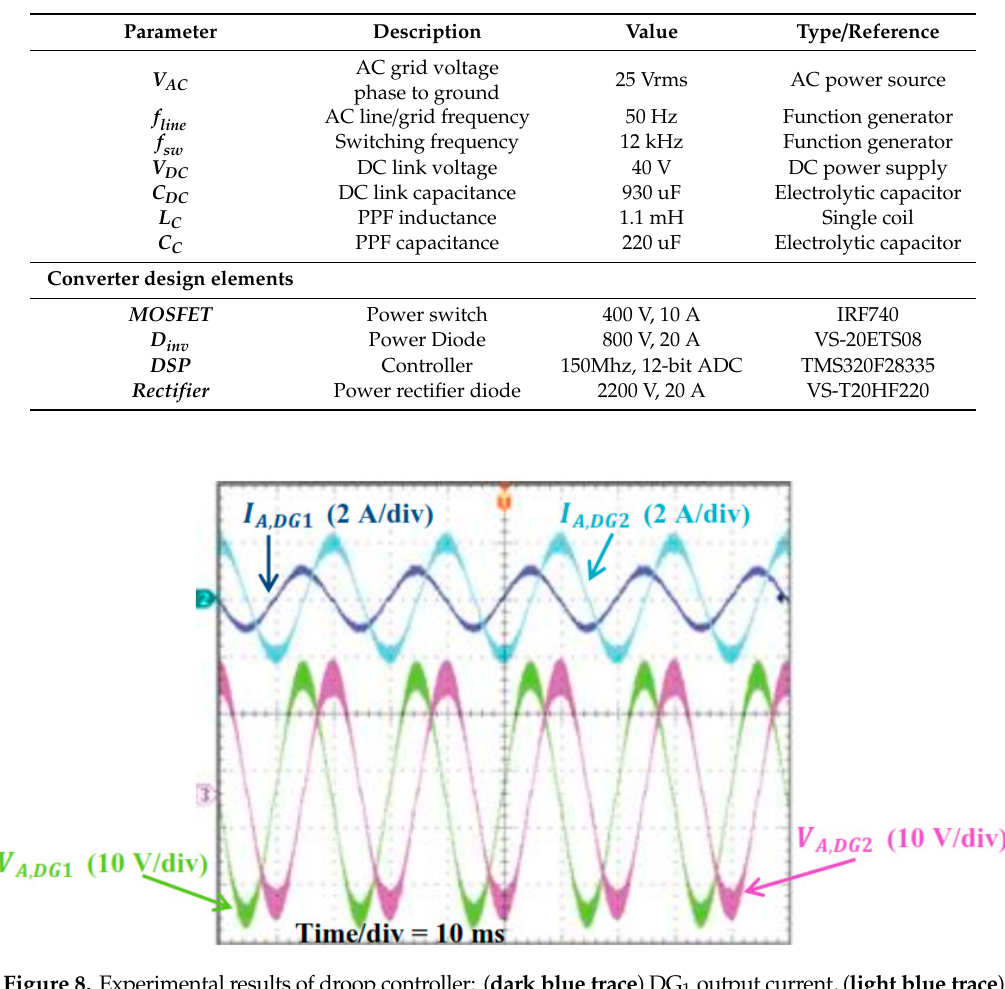
Figure 9. Experimental results of proposed controller: ( dark blue trace ) DG 1 output current, ( light blue trace ) DG 2 output current, ( green trace ) DG 1 output voltage, ( pink trace ) DG 2 output voltage. The two-phase currents in each of the DG outputs, respectively, are in good agreement with regard to the measured I p-p quantities. In the following scenario the RL load is replaced by a three- phase diode rectifier. Figure 10 documents how MSCM performance under such PCC load. It is clear that the high harmonic content current is not an obstacle to deteriorate the power sharing functionality of the proposed control scheme. Therefore, both DG currents have similar profile and amplitude. Naturally, it is observed some voltage waveform degradation which can be fixed with appropriate filtering to meet international standards.